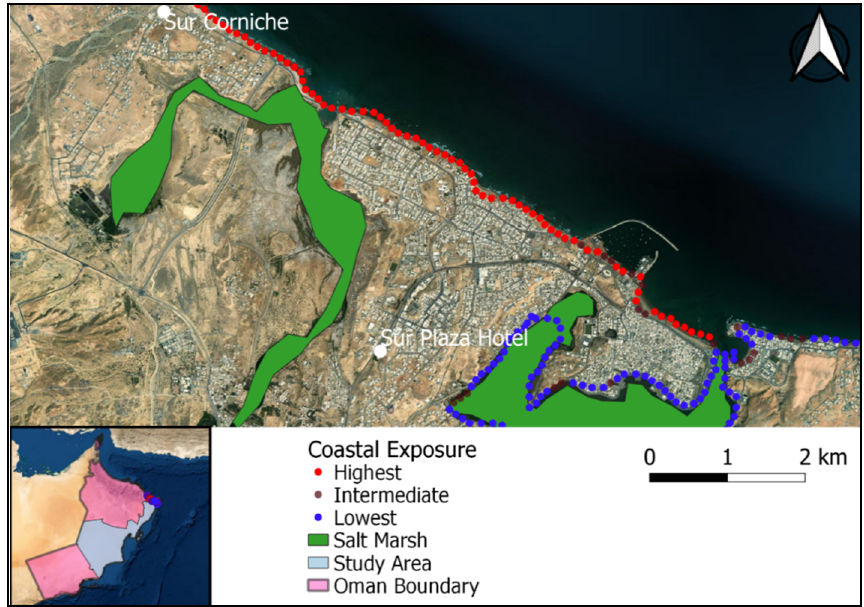
Figure 7. Example of coastal communities’ exposure in Sur City with no natural habitats along the shoreline.